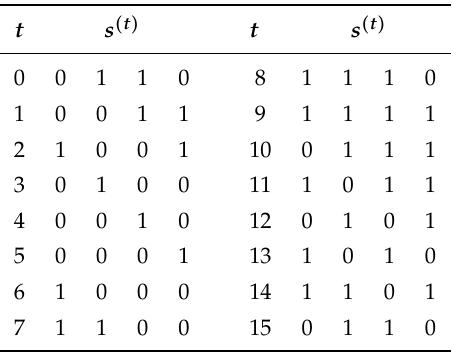
Table 1. Values of the LFSR (cid:104) 4,1 + x + x 4 (cid:105) whose initial state is [ 0,1,1,0 ]